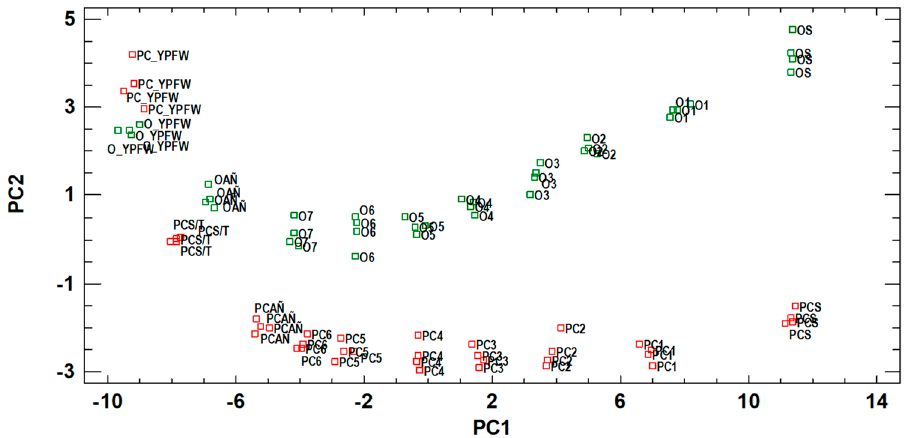
Figure 2. Visual representation of the wines on the two-dimensional plane defined by PC1 (71.03%) and PC2 (9.18%). PC: Palo Cortado; O: Oloroso; YPFW: Young Palomino Fortified Wine; AÑ: Añadas ; S/T: Sobretabla ; S: Solera; the numbers next to the wine names indicate the Criadera